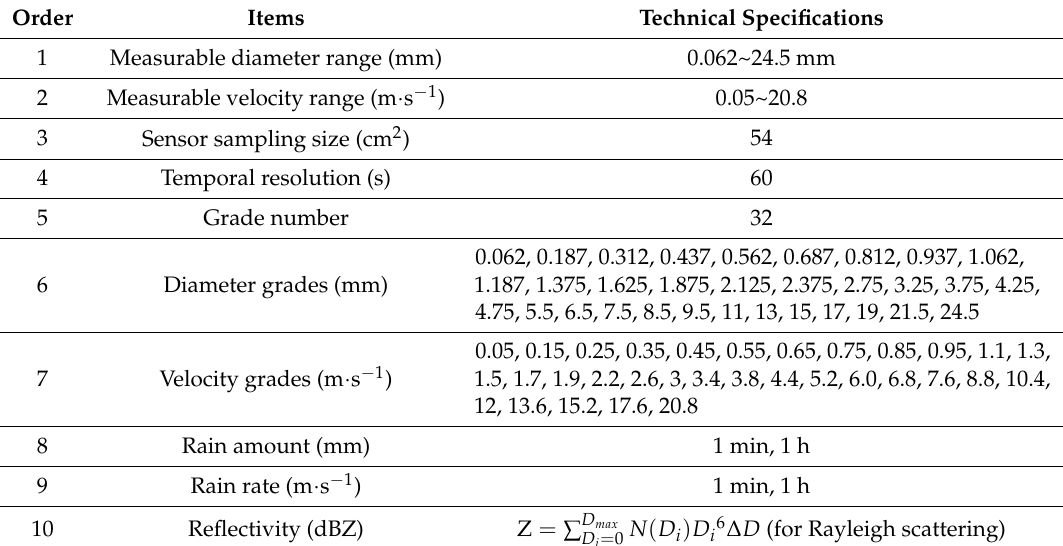
Table 5. Major technical parameters and data for